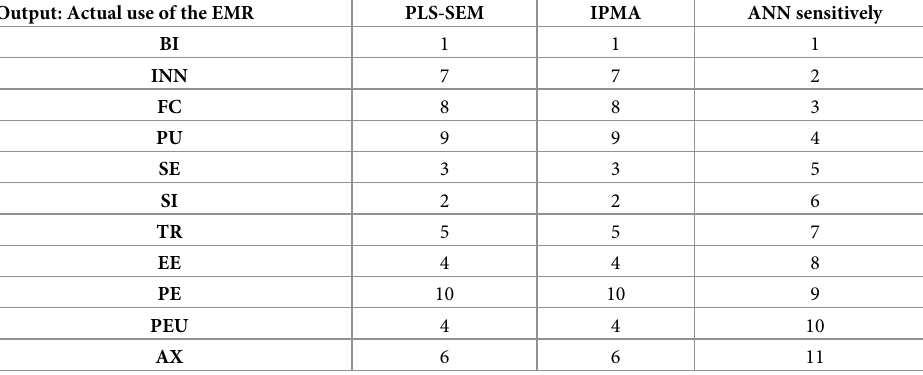
Table 10. Summary of ranking